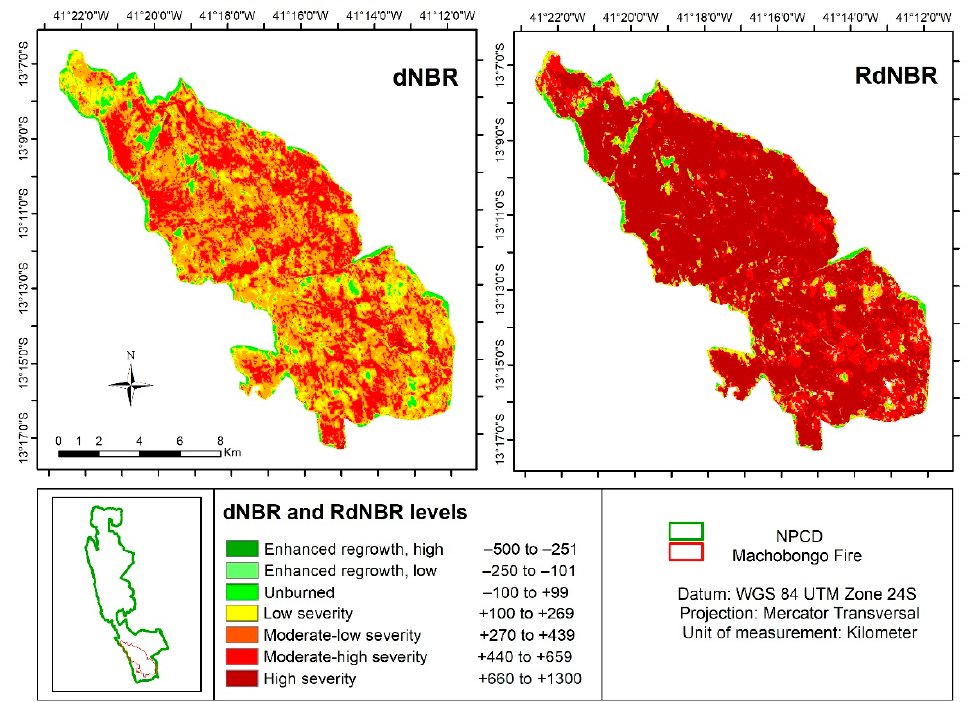
Figure 14. The severity of the fire identified by the dNBR index relating to the Gerais do Machobongo fire (classification by Key and Benson [10]).